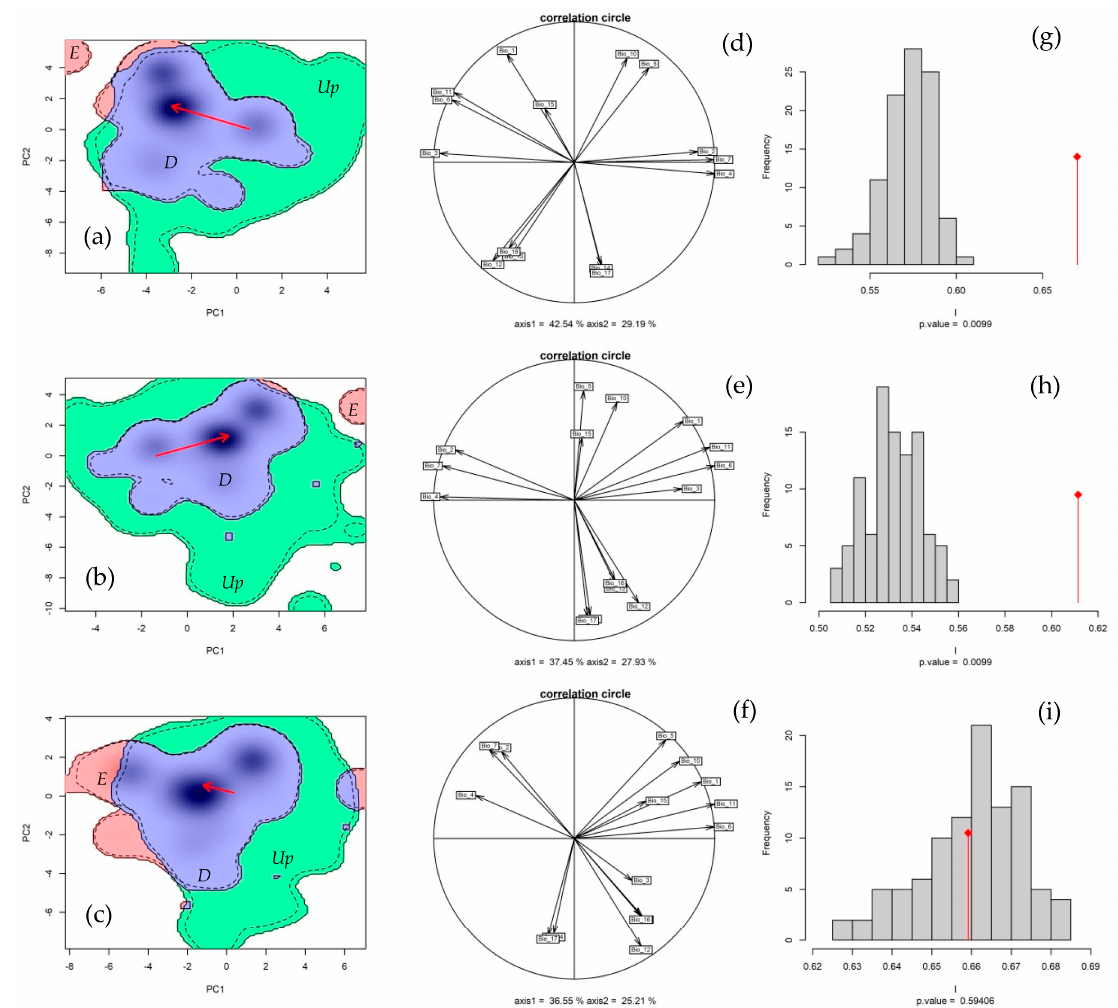
Figure 6. Niche of the species along the two first axes of the PCA ( a – c ) of the native species and ‘invasive’ species. Green ( Pinus ) and blue ( Dendroctonus mexicanus ) ( D ), shading shows the density of the occurrences of the species by cell. The solid and dashed contour lines illustrate, respectively, 100% and 95% of the available (background) environment, E represents niche expansion and Up the non-overlapping niche between pine species and the ‘invasive’ species. The arrows represent the change of the niche centroid of the ‘invasive’ species, relative to the ‘native’ species. The contribution of the climatic variables on the two axes of the PCA and the percentage of inertia explained by the two axes ( d – f ). Histograms show the observed niche similarity I between the two ranges (lines with a diamond) and simulated niche similarity (grey bars). Pinus leiophylla ( a , d , g ), Pinus teocote ( b , e , h ) and Pinus devoniana ( c , f , i ).